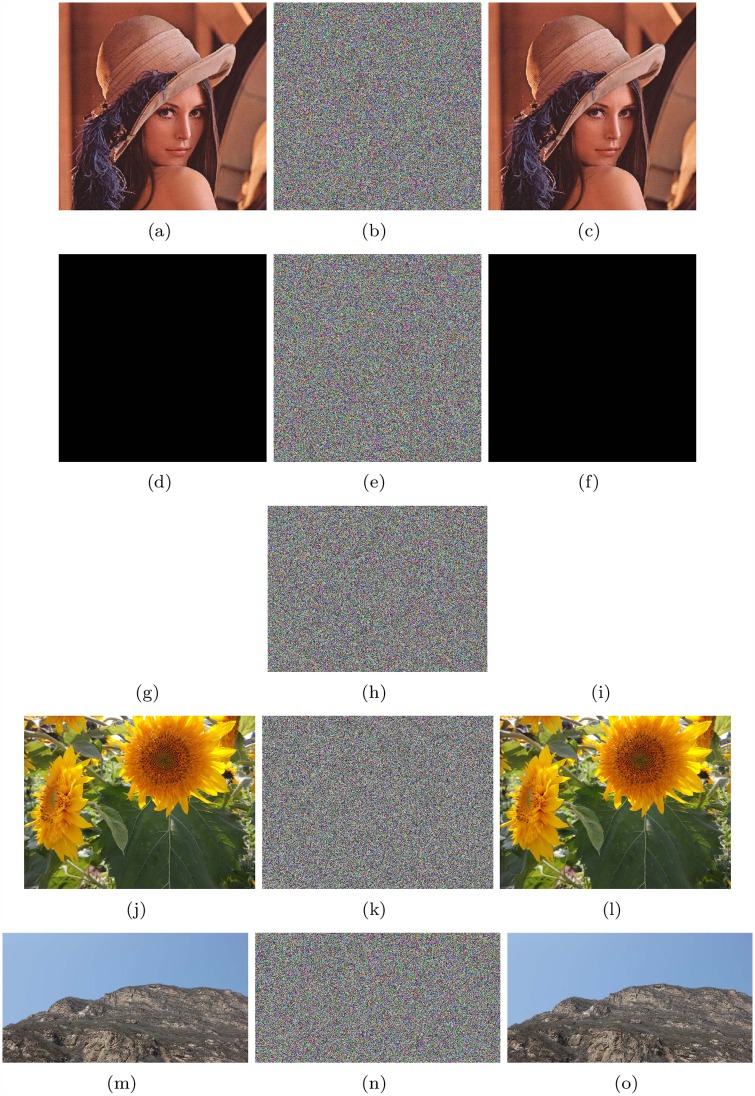
Results of Lena, all-zero image, white, flower and mountain.(a) Plain image Lena; (b) Encrypted image of Lena; (c) Recovered image of Lena; (d) all-zero image; (e)Encrypted image of all-zero image; (f)Recovered image of all-zero image; (g) Plain image white; (h) Encrypted image of white; (i) Recovered image of white; (j) Plain image flower; (k) Encrypted image of flower; (l) Recovered image of flower; (m) Plain image mountain; (n) Encrypted image of mountain; (o) Recovered image of mountain.